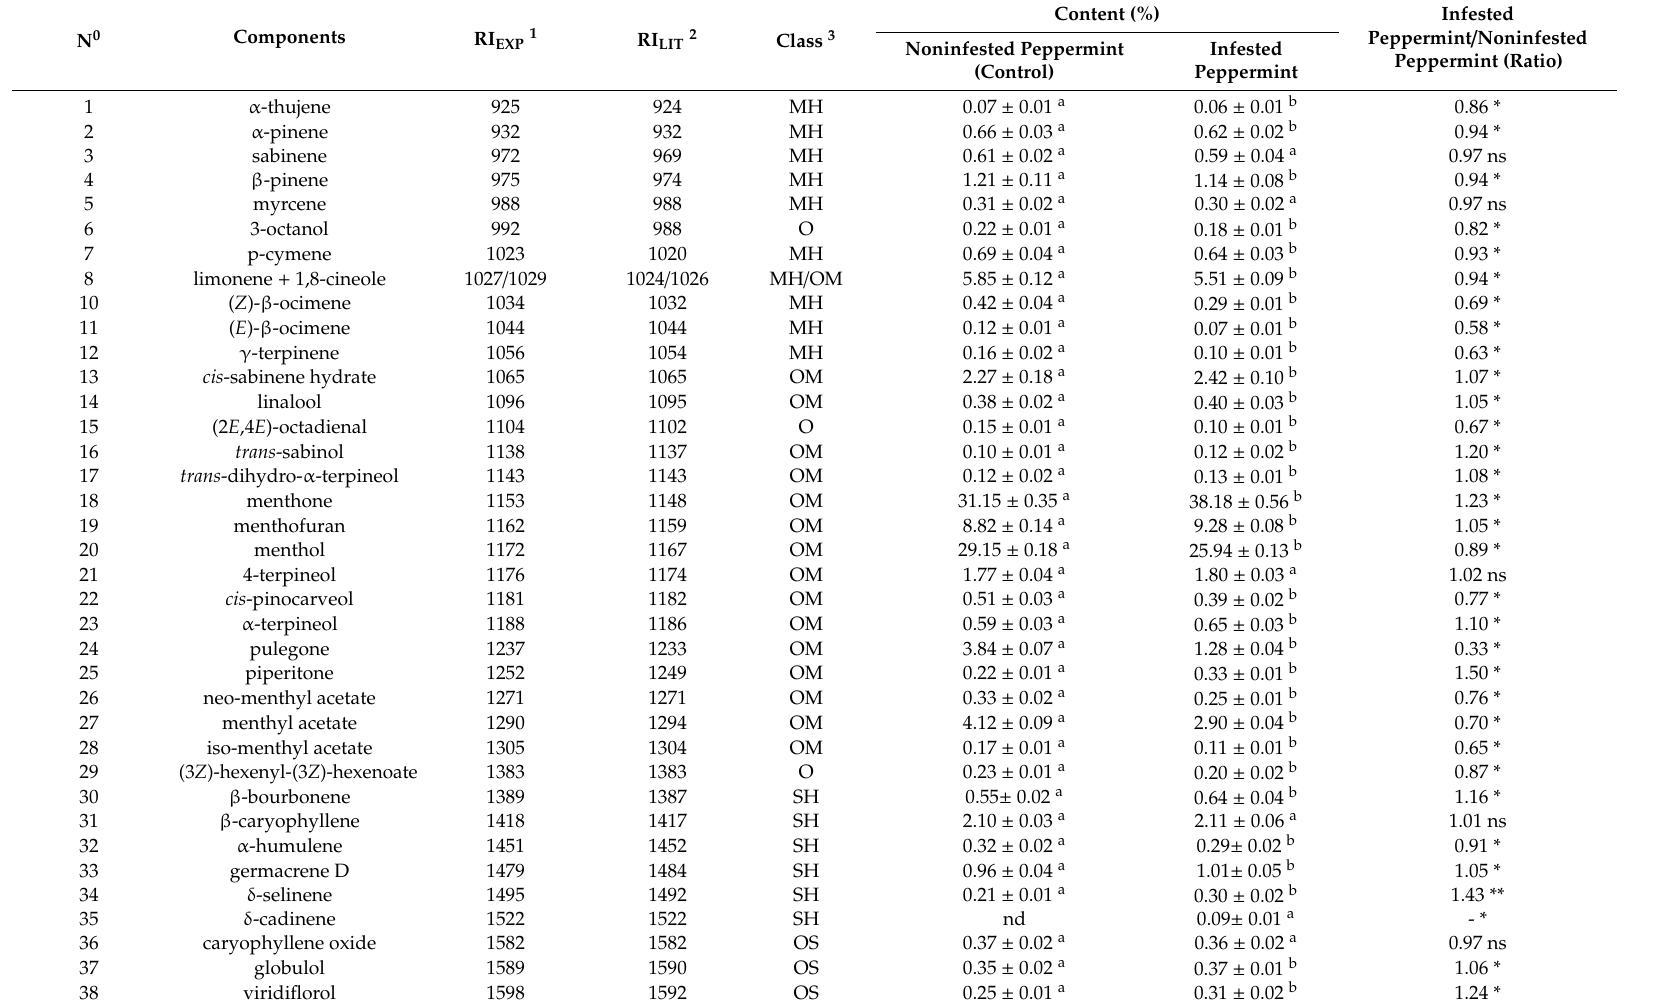
Table 3. Chemical compositions of peppermint essential oils (noninfested and infested plants). N